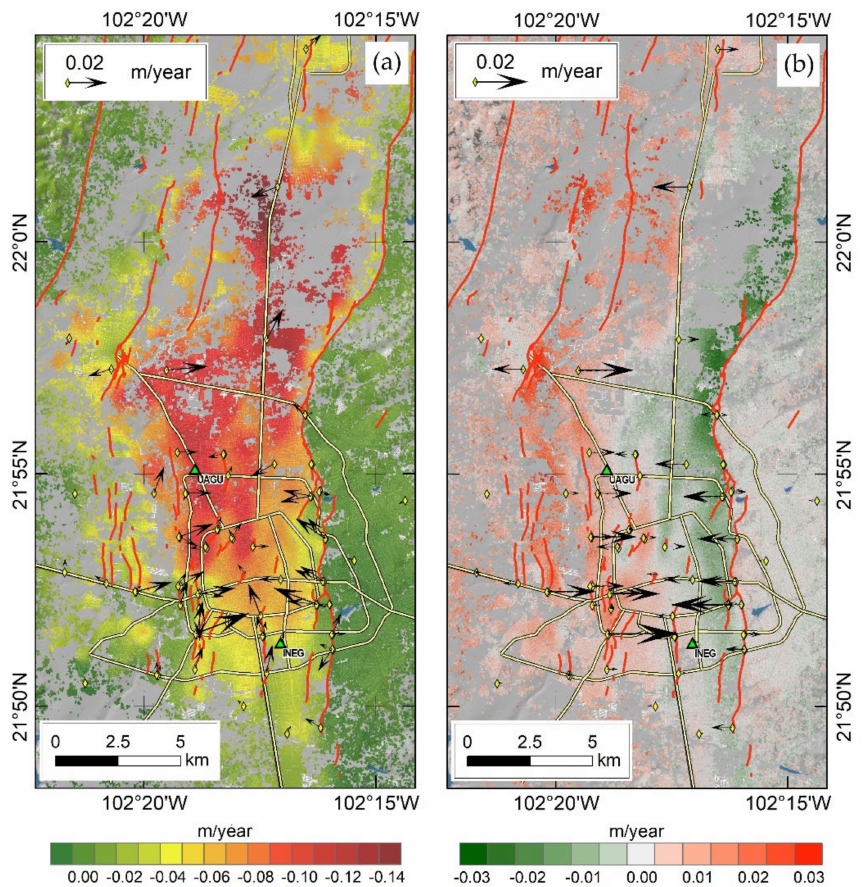
Figure 8. Horizontal velocities from GNSS data at the benchmarks and permanent stations: ( a ) horizontal velocity vector [ V E V N ] plotted over PSI-derived vertical velocities and ( b ) only east- west velocities ( V E ) plotted over PSI-derived east-west velocities. North-south displacement rates were limited to the ± 18 mm/year range, with most benchmarks recording less than ± 5 mm/year, and only a few exhibiting higher rates (Figure 8a). These were in proximity to Crena (FG24 and FG24B, with V N of +10 and +18 mm/year, respectively), Del Valle II - Pirules (FG18, with +12 mm/year), and Vicente Guerro (FG28A, with +12 mm/year) faults, as well as at benchmarks FG25 (+18 mm/year) and FG22C (+17 mm/year) which were close to the Jardines-Lindavista fault in the southern sector, and to the Oriente fault at benchmarks FG09 and FG09A (see benchmark locations in Figure 1b). Negative V N were less frequent and were only recorded at benchmark FG21A near San Marcos fault ( − 18 mm/year) and FG26 at the hanging wall of the Oriente fault ( − 12